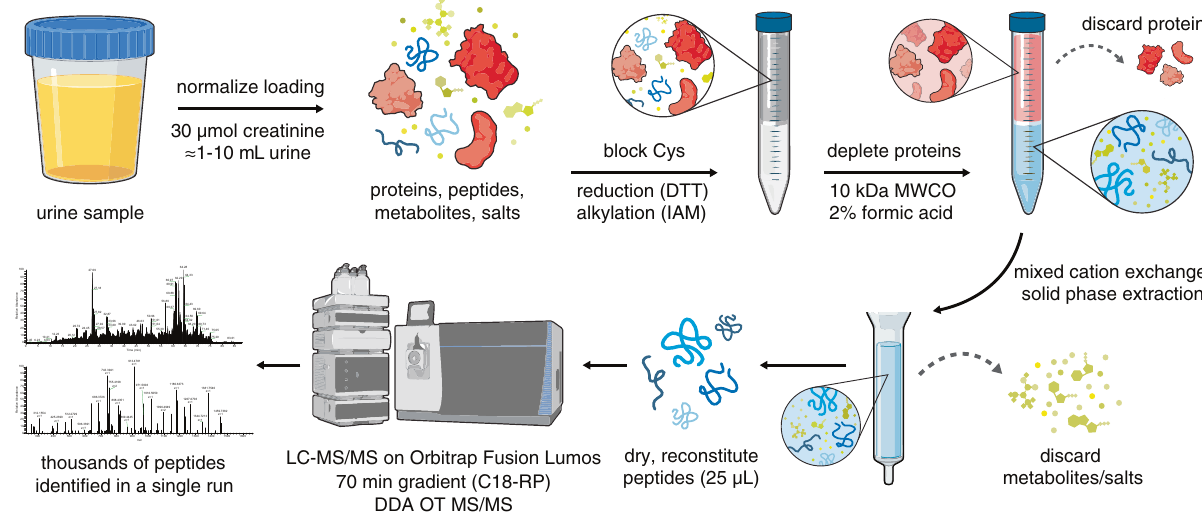
Fig. 1 An ef fi cient chemical extraction and LC – MS/MS work fl ow for urinary peptidomic analysis. Urine sample volumes are fi rst normalized based on creatinine measurement. To prevent the formation of intra- or intermolecular disul fi de bonds that would confound downstream data analysis, cysteine (Cys) residues are reduced with dithiothreitol (DTT) and alkylated with iodoacetamide (IAM). Proteins are depleted using a centrifugal fi ltration device with a molecular weight cutoff (MWCO) of 10 kDa under acidic denaturing conditions. The fi ltrate is processed using a mixed cation exchange solid-phase extraction column to remove metabolites and salts that interfere with LC – MS/MS analysis. After extensive washing, peptides are eluted from the column with methanol containing 5% ammonium hydroxide. Eluted peptides are dried in a centrifugal vacuum concentrator and reconstituted in water. Peptides are separated by nano-liquid chromatography (LC) on a reversed-phase column (RP-C18) and analyzed by tandem mass spectrometry (MS/MS) on an Orbitrap Fusion Lumos mass spectrometer operated in the data-dependent acquisition (DDA) mode, with precursor and fragment ions analyzed in high resolution in the Orbitrap (OT). The resulting LC – MS/MS data are searched against the desired databases (e.g., the human and wheat proteomes). The experimental work fl ow takes ~6 h to complete and results in the identi fi cation of thousands of